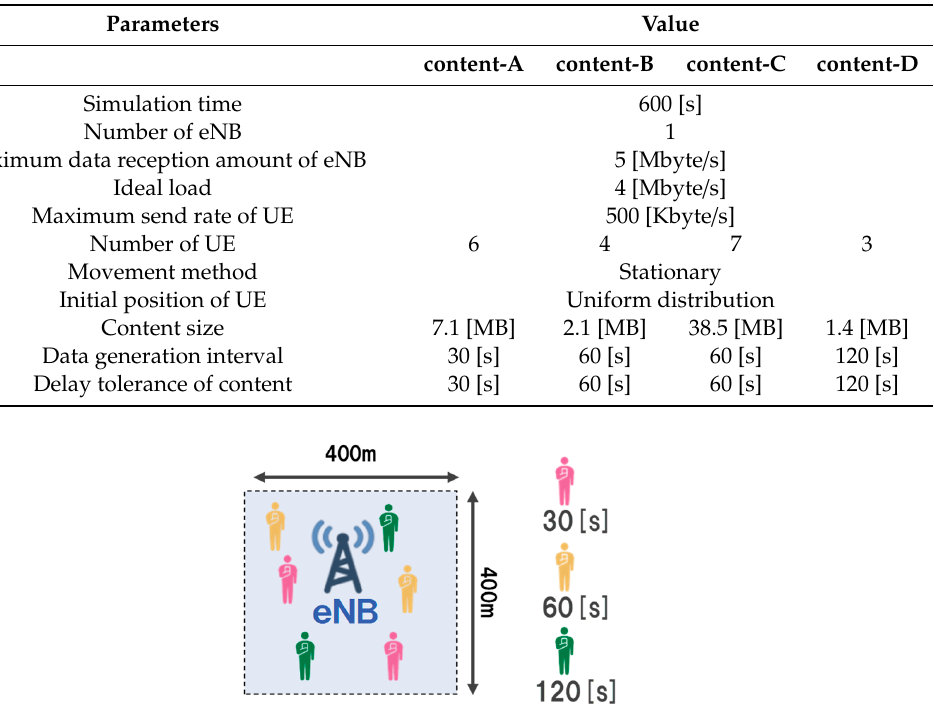
Table 5. Scenario for comparing performance.